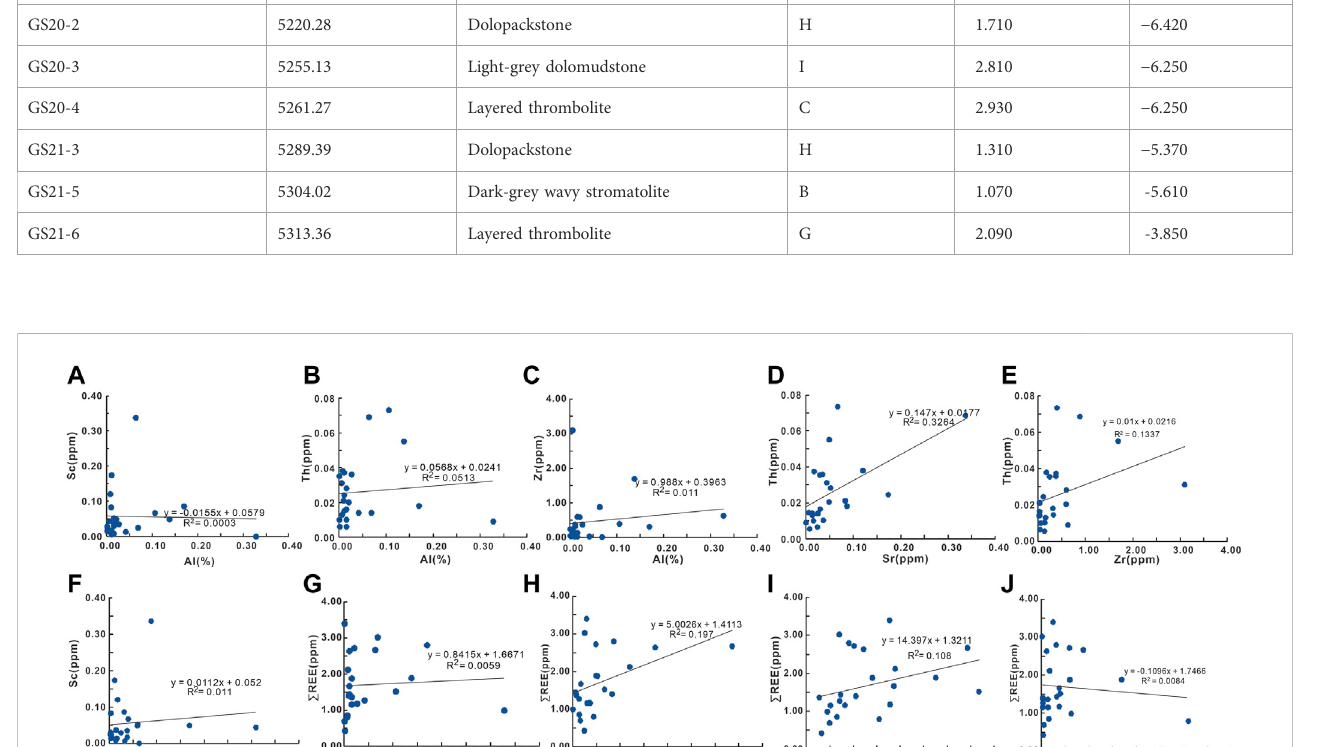
to − 4.800 ‰ (mean value = − 6.910 ‰ ), while those of the platform interior lithofacies associations range from − 7.060 ‰ to − 3.450 ‰ (mean value = − 5.608 ‰ ), which may indicate higher salinity of platform interior lithofacies associations (Figure 11D). In addition to salinity comparison, (La/La*) SN has been used to analyze the restrictiveness of various depositional settings: lower (La/La*) SN